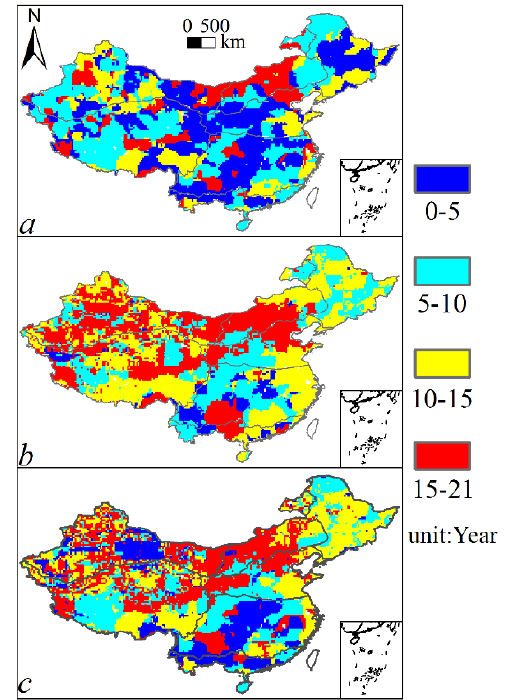
Figure 10. The spatial distribution of the main periods in the 12-month ( a ) SPI, ( b ) SSI, and ( c )